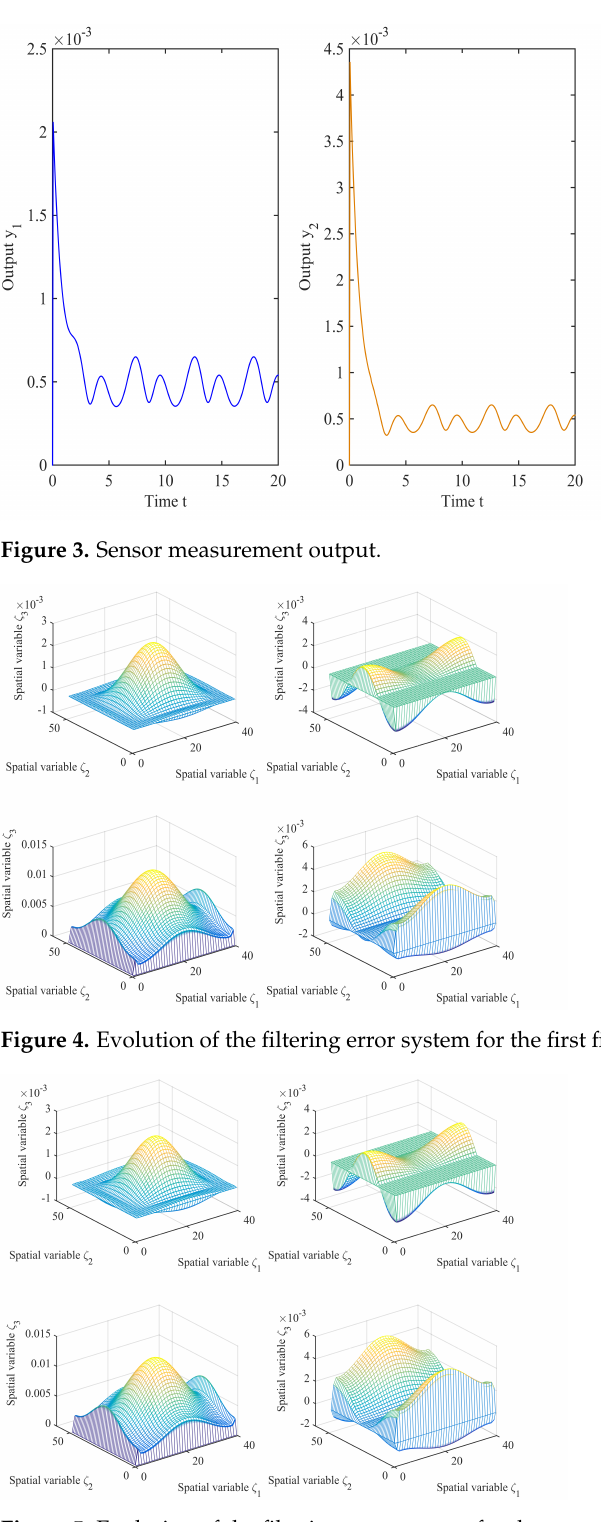
Figure 5. Evolution of the filtering error system for the second